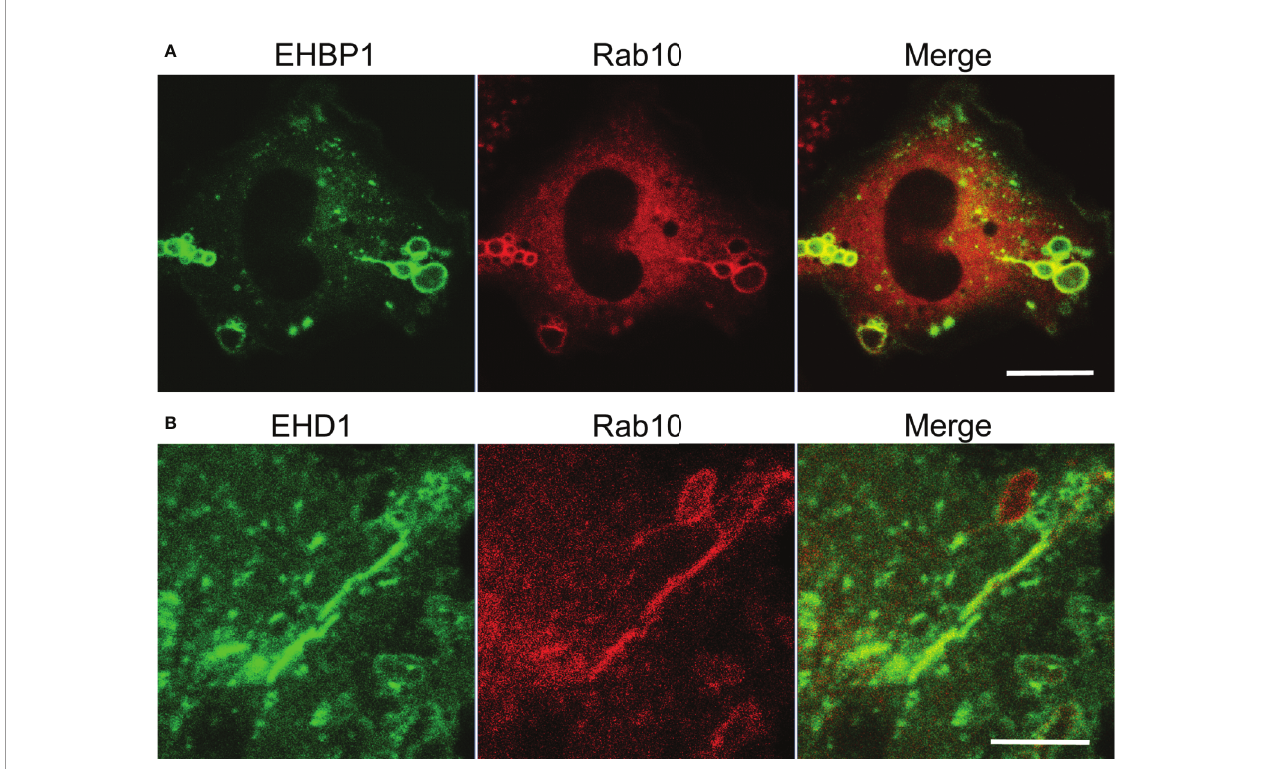
FIGURE 5 | Localizations of EHBP1 and EHD1 on Rab10-positive premacropinosomes and tubules. (A) EHBP1 colocalized with Rab10 in premacropinosomes and tubules. Scale bar = 10 m m. (B) EHD1 predominantly localized on Rab10-positive tubules extended from premacropinosomes. Scale bar = 5 m m. Corresponding movies are available in the ( Supplementary Material Movies 7 , 8